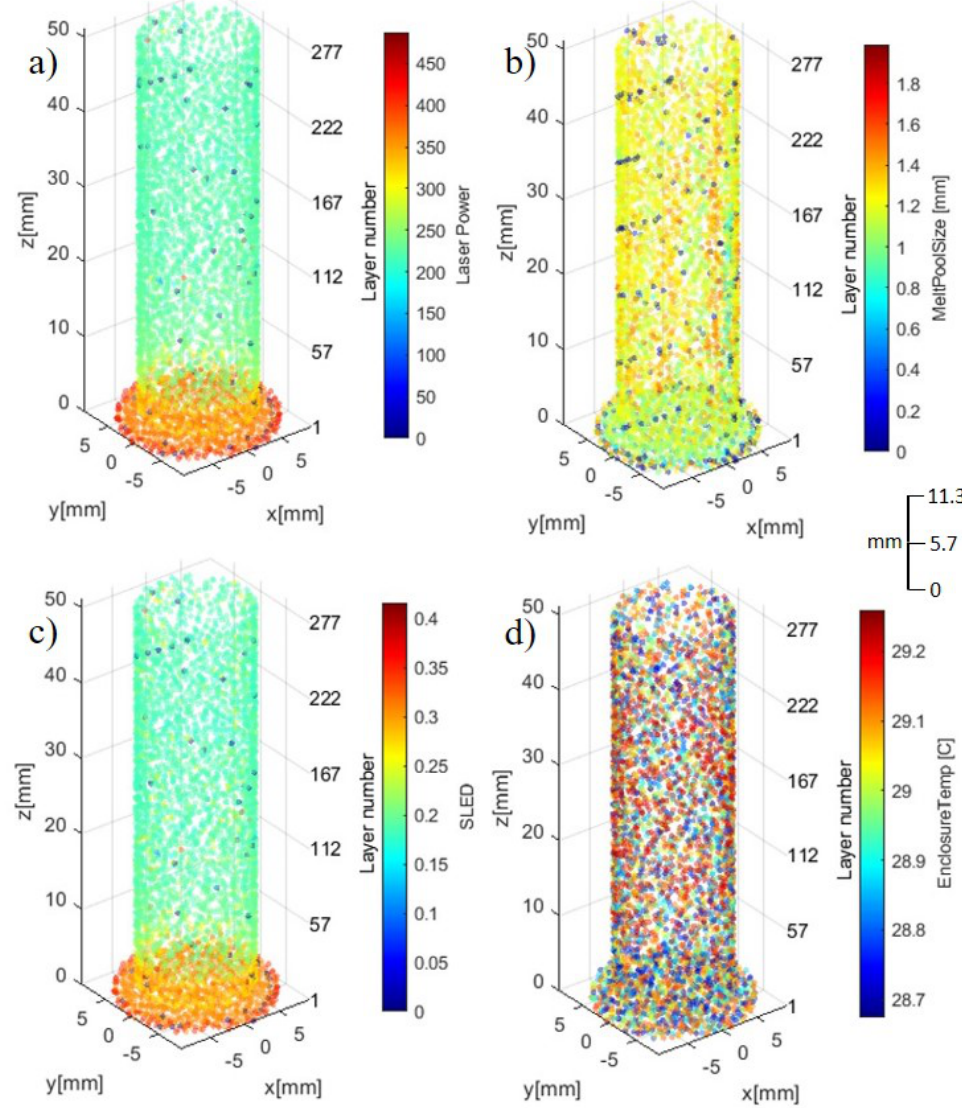
Figure 4. Synchronously collected process parameters: ( a ) LP, ( b ) MPS, ( c ) SLED, and ( d )